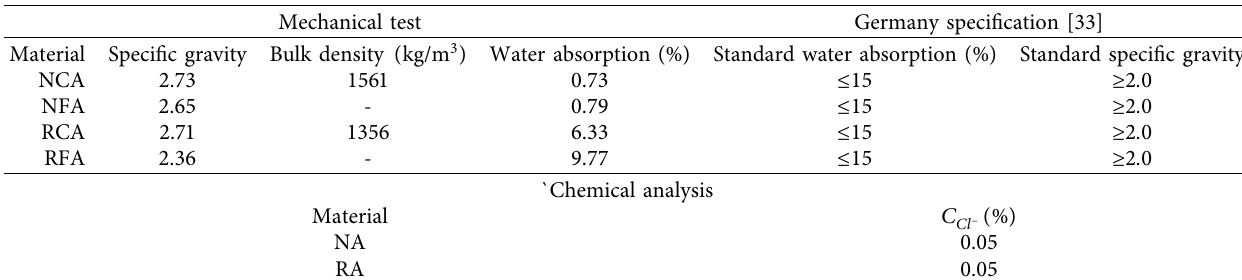
Table 1: Properties of normal and recycled aggregates.